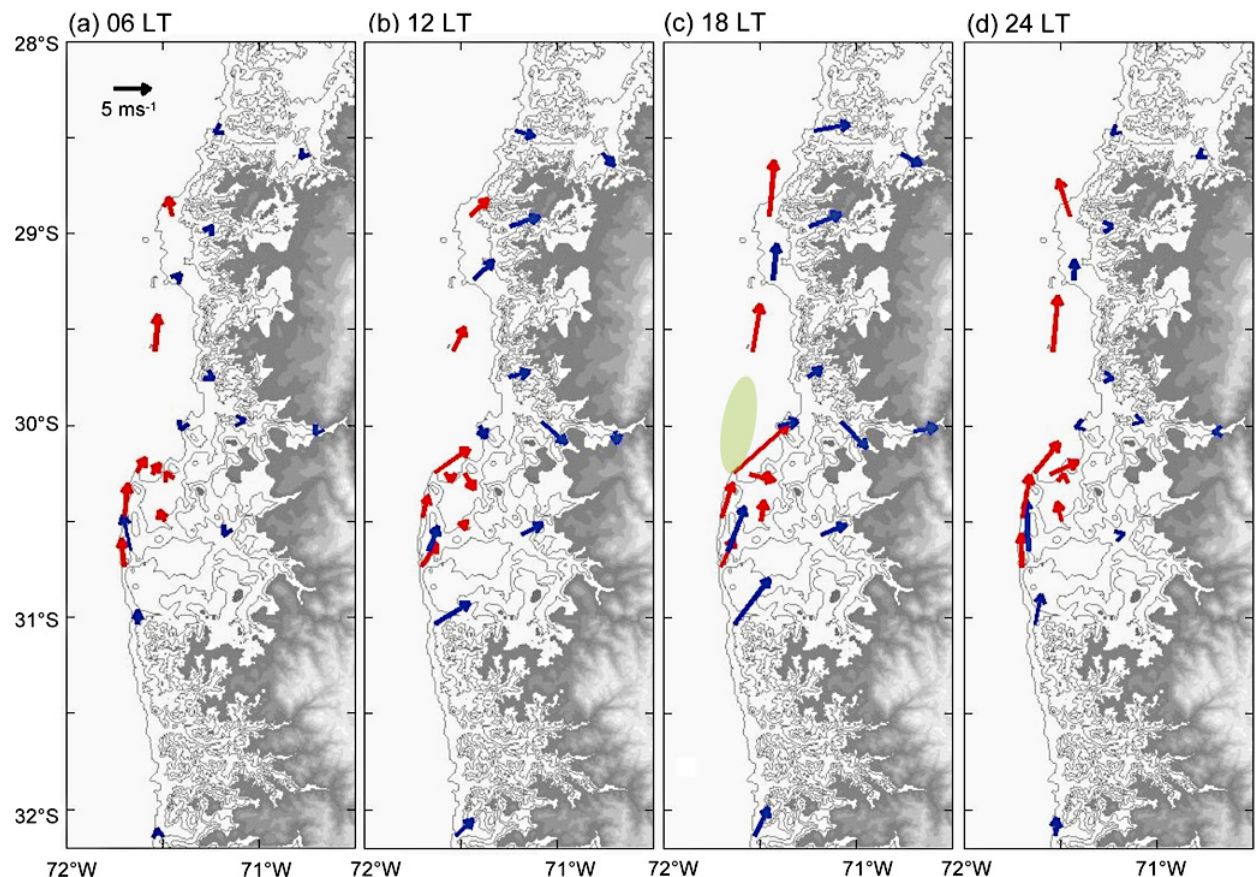
Fig. 12. Mean diurnal cycle of the 10-m winds over the CUpEx area, illustrated by the average wind vectors every 6-h (local time atop of each panel). Red arrows are average winds during CUpEx. Blue arrows are average winds for November/December obtained from different datasets (obtained from Mu˜noz et al., 2003). The green area at 18:00LT (panel c) indicates the core (wind speed ≥ 15ms − 1 ) of the near-shore coastal jet detected in airborne mission 6 (Table 4, see Fig. 13) and obtained from a WRF numerical simulation (3km horizontal resolution) of the CUpEx period described in Rahn et al., 2010. Topographic contours every 250m, shaded above